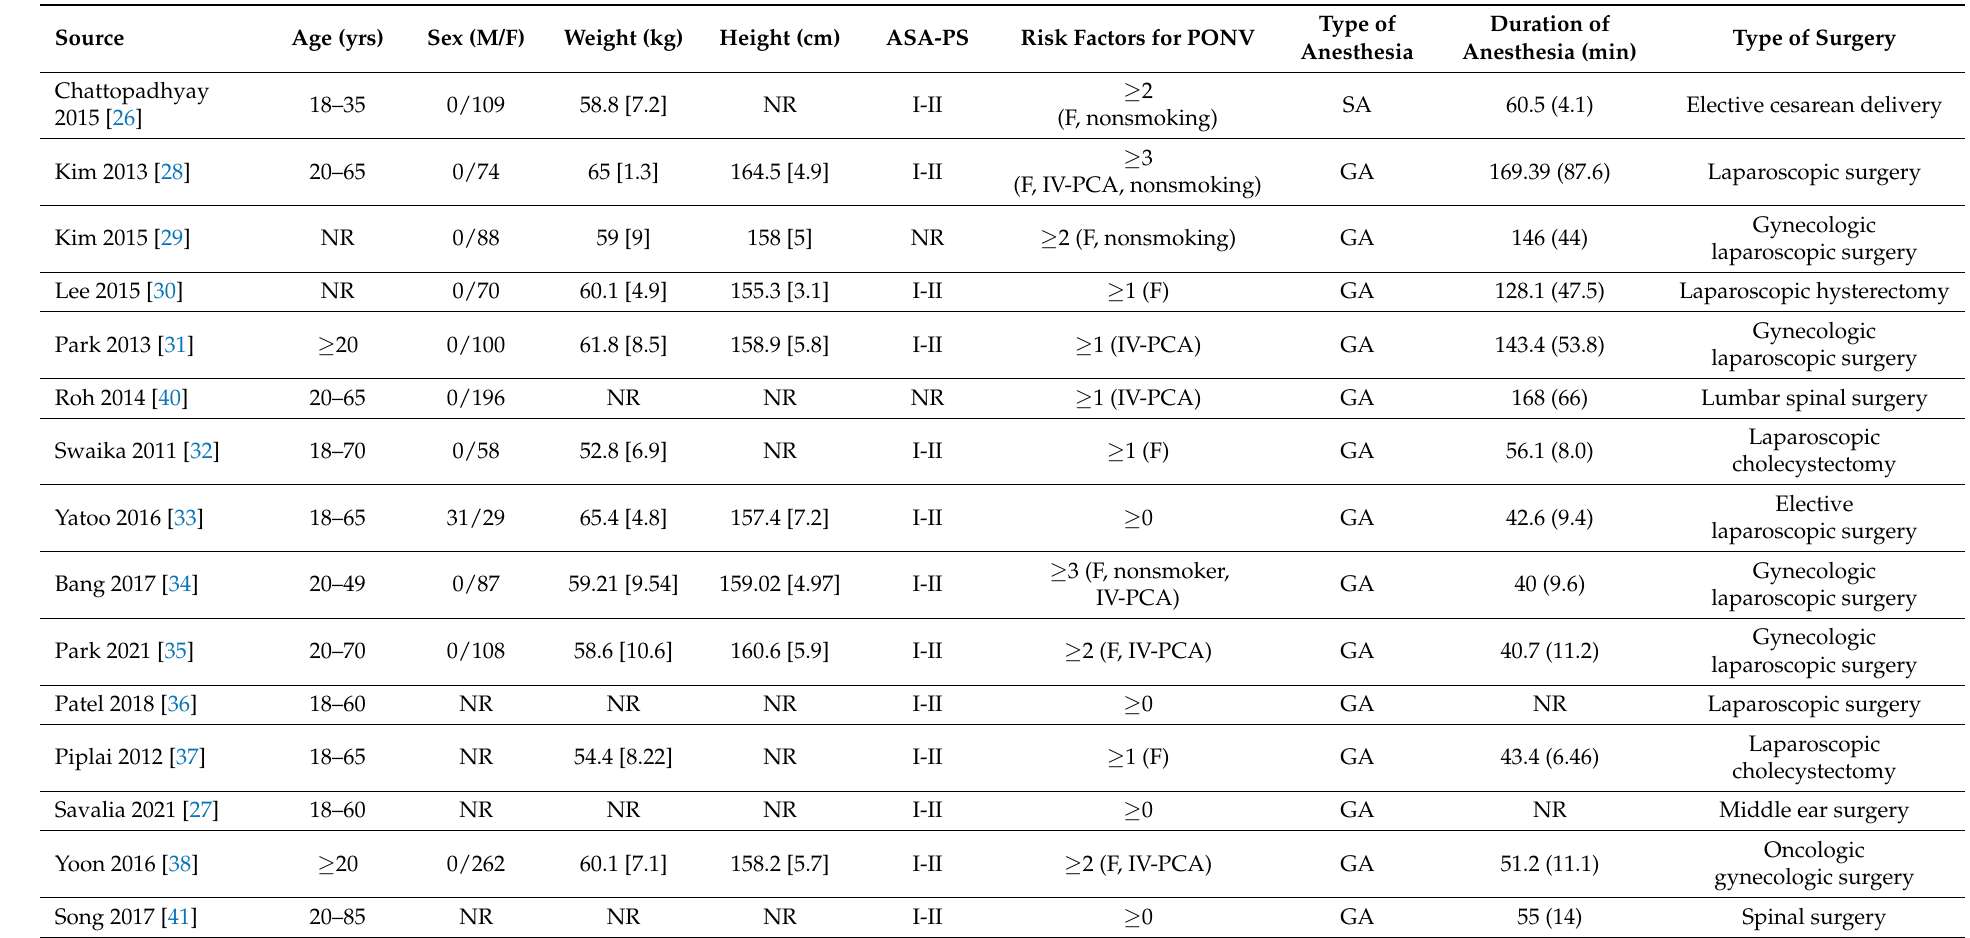
Table 1. Study characteristics of included